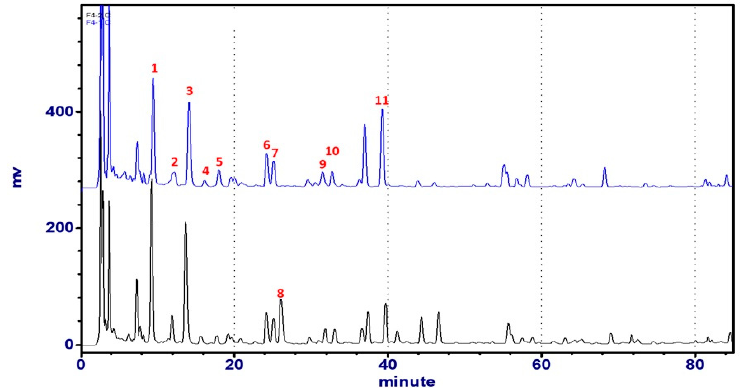
Figure 4. The HPLC-UV profile of Astragali Complanati Semen (254 nm). Blue line: The extract dissolved in MeOH was freshly prepared. Black line: The extract dissolved in MeOH was stored at room temperature for 3 weeks.